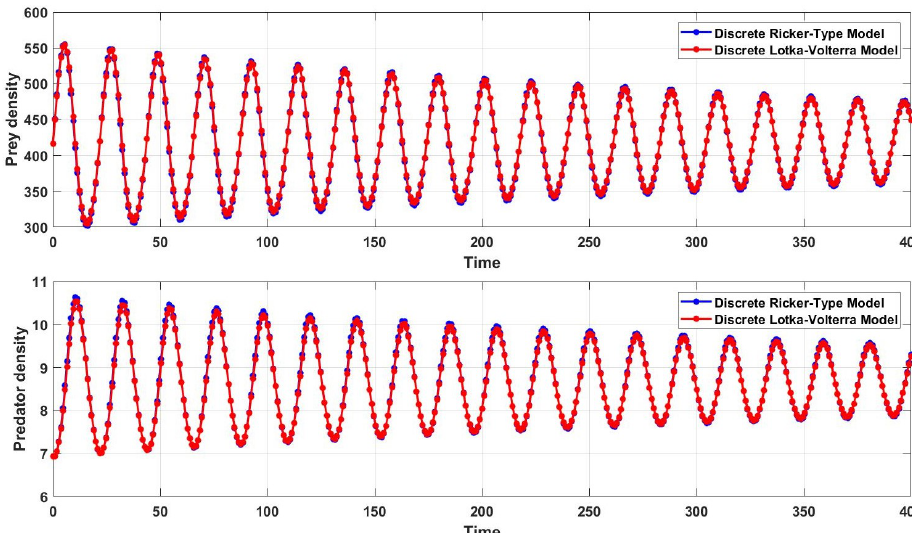
Figure 5. Special behaviour of predator-prey populations for Ricker-type and Lotka-Volterra discrete = 20 models if h = 1 , where K = 2500, γ = 0.01, α = 0.05, c = 0.2 and r = 0.5. Predator-prey 21 θ populations seem to converge to a fixed point at the beginning; however, after a long time, the populations oscillate around the fixed point. Note that this exceptional case occurs only at the upper bound of the fixed-point convergence